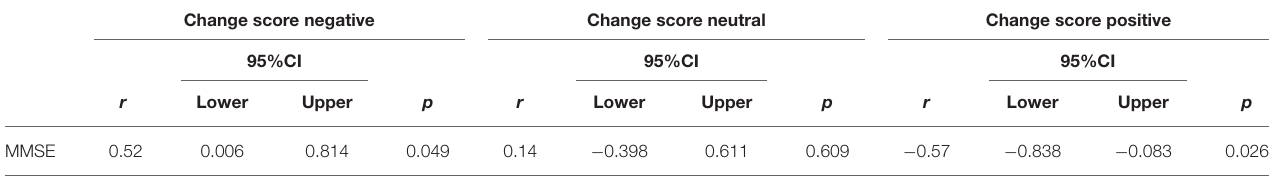
TABLE 5 | Relationship between severity of cognitive impairment and preference change score using Pearson